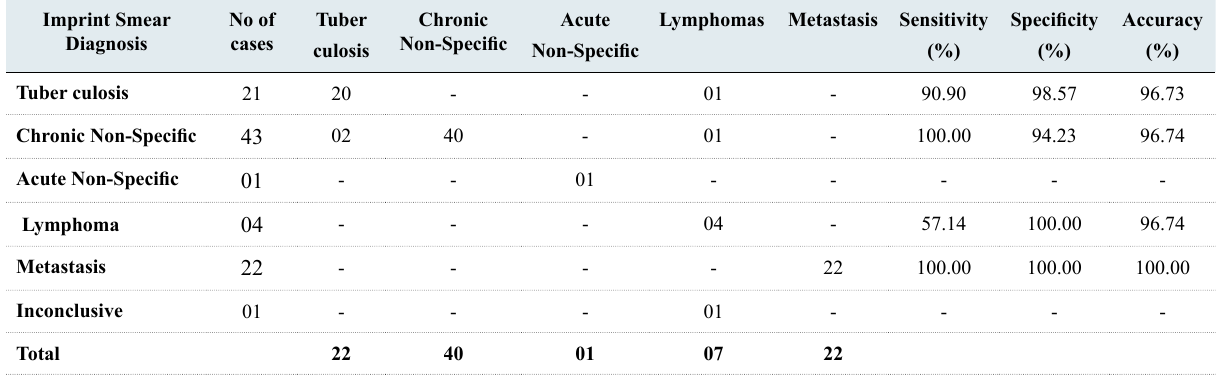
Table 2: Sensitivity, Specificity and accuracy of imprint smear diagnosis in various diseases Imprint Smear